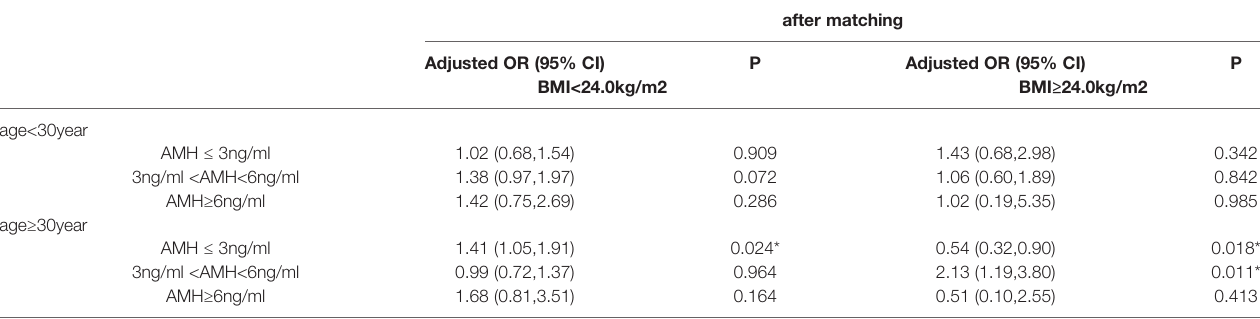
TABLE 4 | Multivariable logistic regression analysis of live birth rate of the GnRH agonist long-acting protocol and GnRH antagonist protocol for women with different AMH, Age and BMI (after PS matching) (the GnRH antagonist protocol group as a reference). after matching Adjusted OR (95% CI) P Adjusted OR (95% CI) P